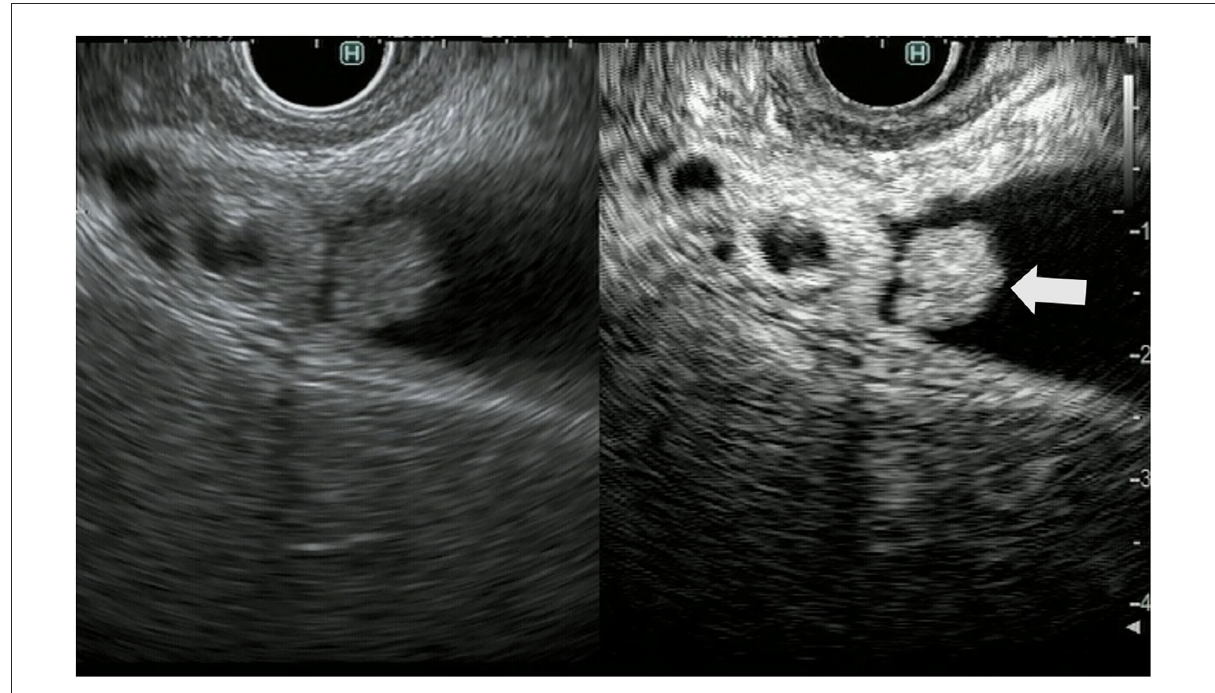
FIGURE3 Contrast-enhanced harmonic endoscopic ultrasound (EUS) for gallbladder polypoid lesions. Gallbladder adenoma: The mass is a polypoid lesion with homogeneous hyperenhancement (arrow).